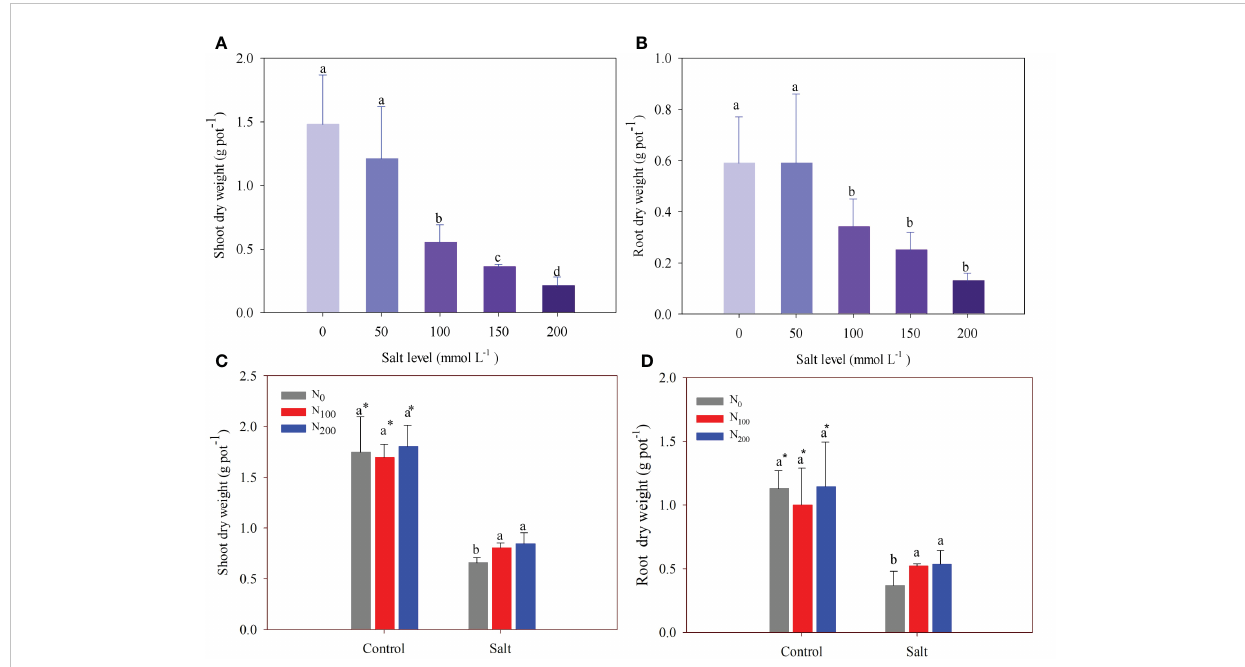
FIGURE 2 Alfalfa shoot (A) and root (B) dry weight in different salt levels in experiment 1. Alfalfa shoot (C) and root (D) dry weight in different nitrogen (N) supply and salt levels in experiment 2. Error bars represent ± SD of the mean. Different letters represent a signi fi cant difference among treatments ( p ≤ 0.05). Asterisks refer to signi fi cant differences between salt levels at the same N fertilizer supply